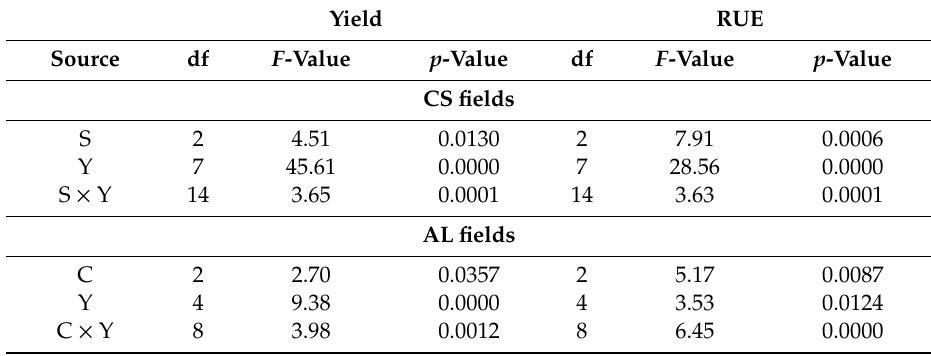
Table 2. Variance analysis of the fixed e ff ect of species (S), cultivars (C), and year (Y) on dry matter yields and RUE of the biomass produced. Yield